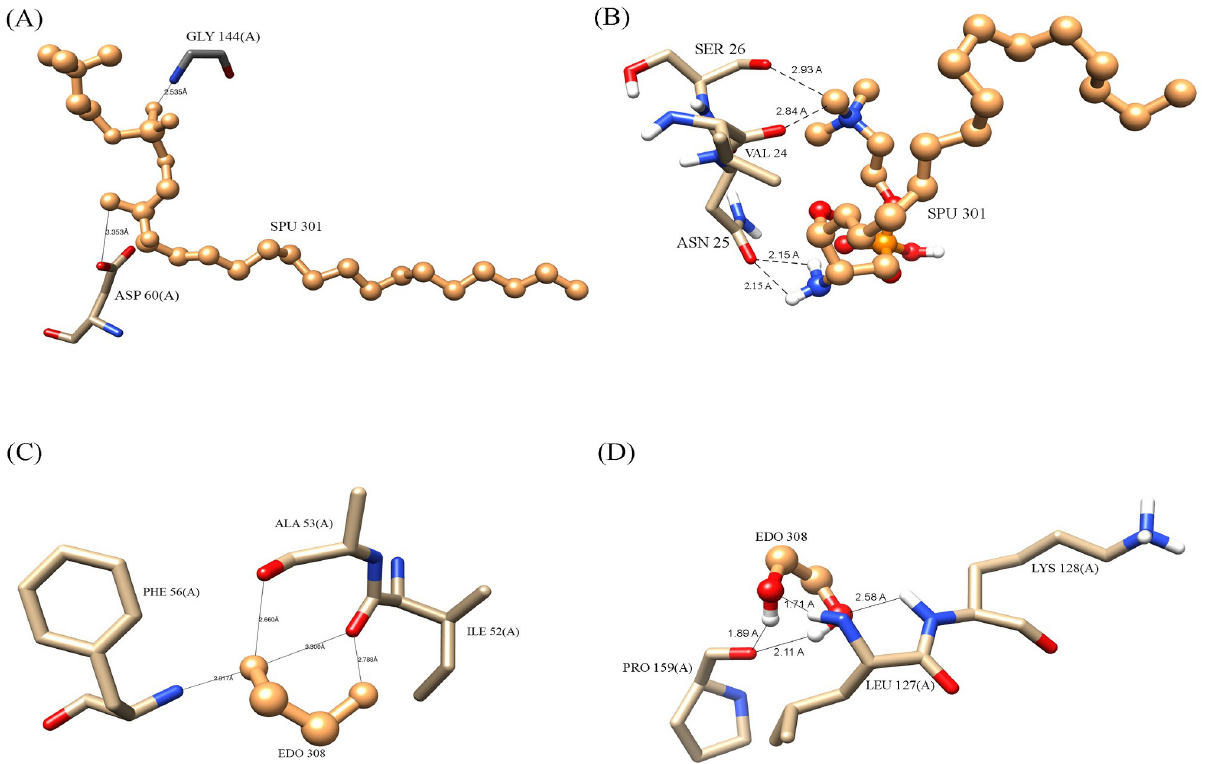
Fig 8. Ligand interaction change with protein structure of ACD11 because of A15T